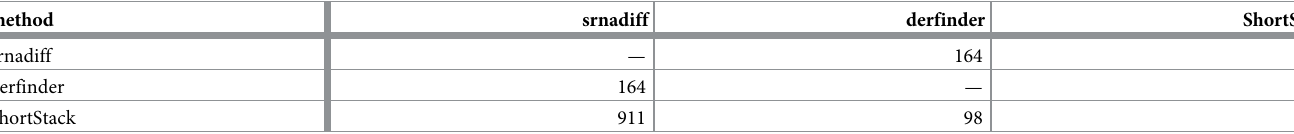
Table 3. Comparison of the results given by the srnadiff, derfinder, and ShortStack methods on the D. melanogaster dataset. See Table 1 for the meaning of each column.